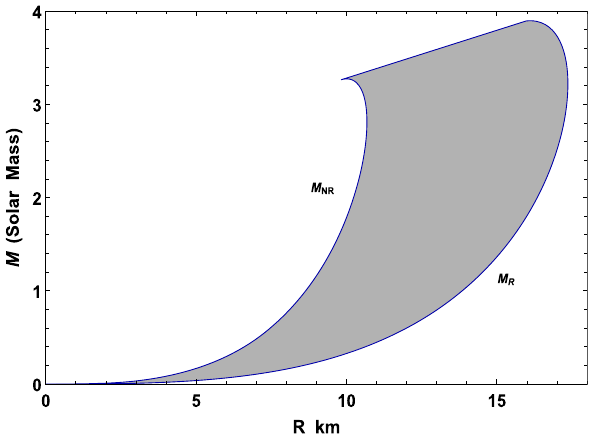
Fig. 10 ν – M graphs for a = 0 . 001 km − 2 and β = 0 . 2